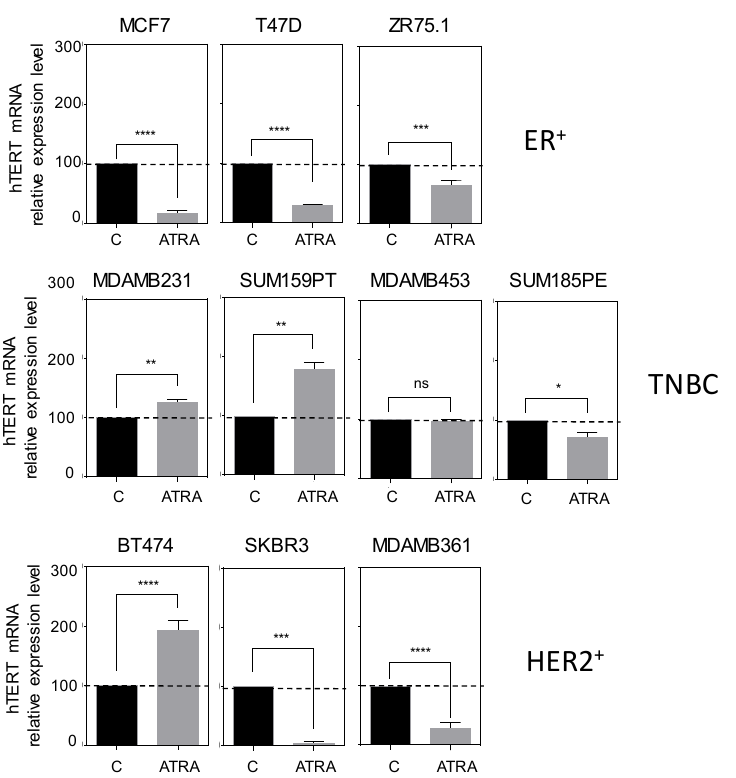
Figure 2. hTERT mRNA expression upon ATRA treatment of breast cancer cell lines. Histograms represent the relative expression of hTERT in ATRA-treated cells compared to non-treated cells. The normalized hTERT expression of non-treated cells was set to 100. t-Student unpaired two-tailed. * p < 0.05; ** p < 0.01;*** p < 0.001; **** p < 0.0001; ns, non-significant.